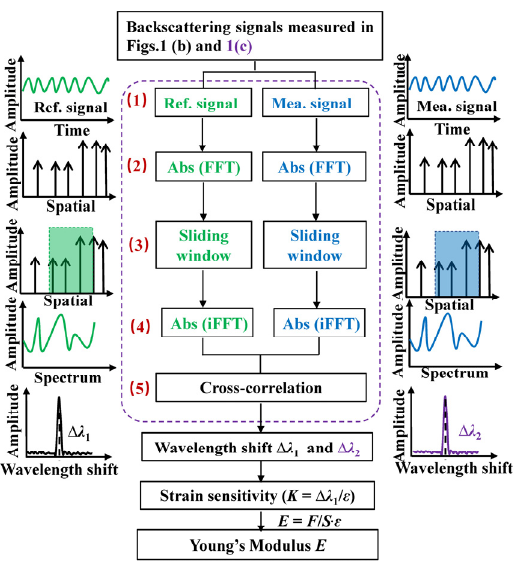
Figure 2. Signal demodulation process for calculating Young’s modulus through the backscattering signals measured in Figure 1. The Ref. and Mea. signals are illustrated by green and blue curves, respectively.